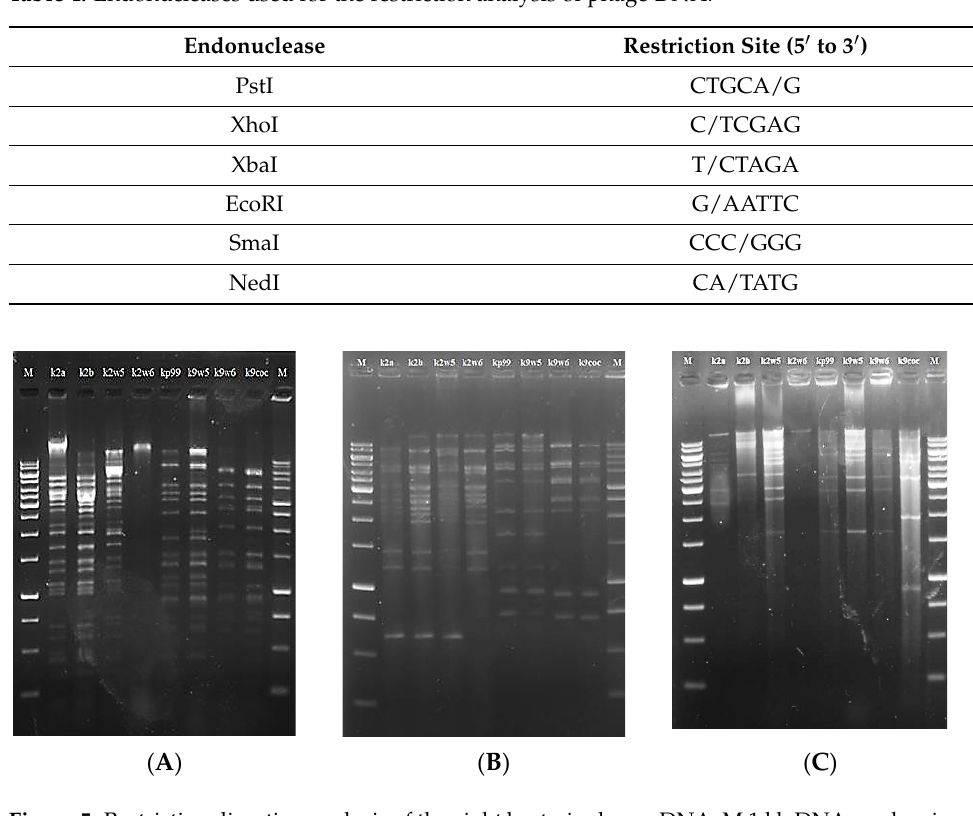
Table 4. Endonucleases used for the restriction analysis of phage DNA.